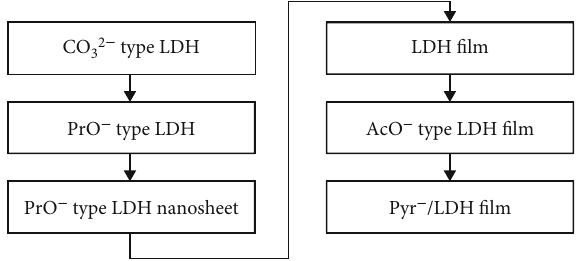
Figure 1: Flow chart of the experimental procedure to prepare the Pyr − /LDH fi